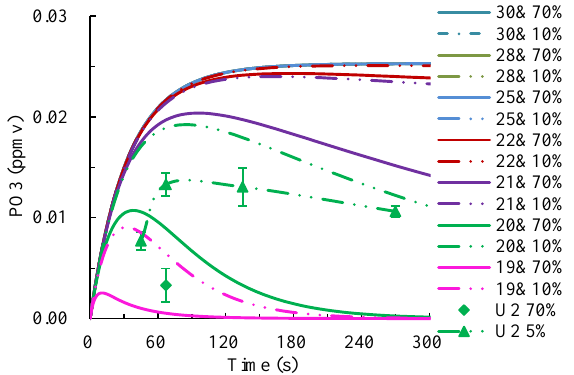
Fig. 7. Sensitivity simulation for the exponent of the reaction rate constant of PO3 and water. The number before “&” is the negative exponent, and the number after “&” is the relative humidity (RH). For example, 30&70% means the model is performed with a rate constant of 1.5 × 10 − 30 cm 3 molecule − 1 s − 1 and a RH of 70%. U2 70% and U2 5% represent the observed unknown2 time series at 70% RH and 5% RH, respectively.